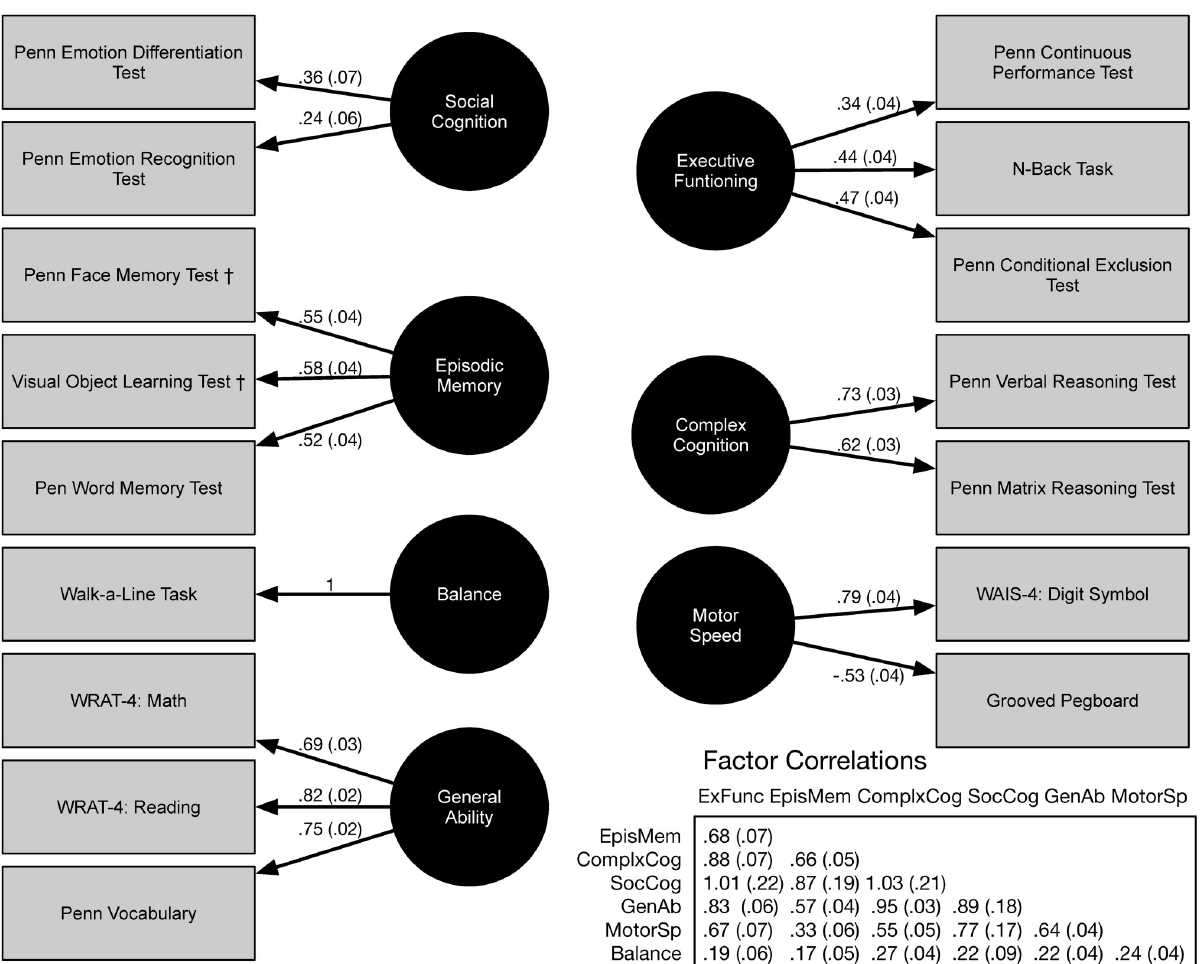
Fig 1. Confirmatory factor analysis estimates of the Gur+ Model for the NCANDA suite of tests.